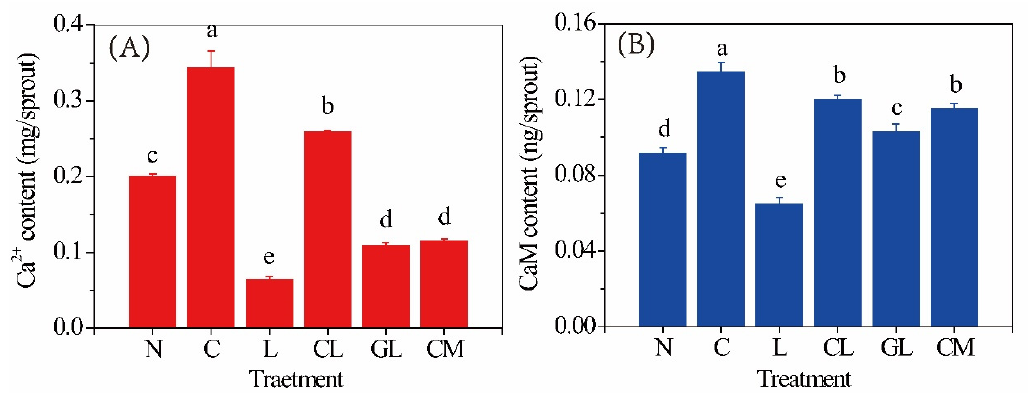
Figure 3. ( A ) Content of Ca 2+ (mg/sprout) and ( B ) calmodulin (CaM; ng/sprout) in soybean sprouts (n = 3). Sprouts in all treatments had a dry weight at around 0.12 g. Treatments were as follows: N: NaCl; C: NaCl + CaCl 2 ; L: NaCl + LaCl 3 ; CL: NaCl + CaCl 2 + LaCl 3 ; GL: NaCl + GABA + LaCl 3 ; CM: NaCl + CaCl 2 + 3-mercaptopropionate (3-MP). Values bearing different letters are significantly